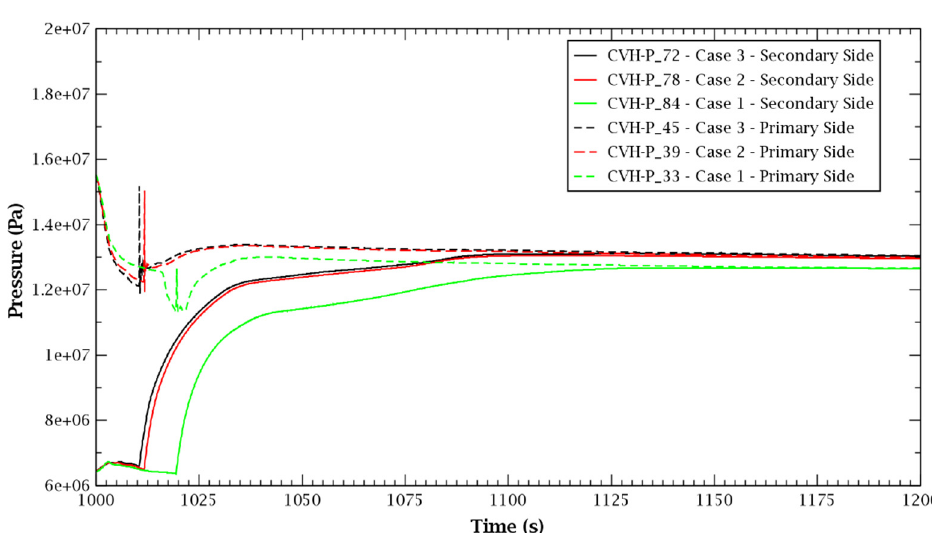
Figure 8. Pressure trend after the rupture: primary and secondary sides, 1000–1200 s.